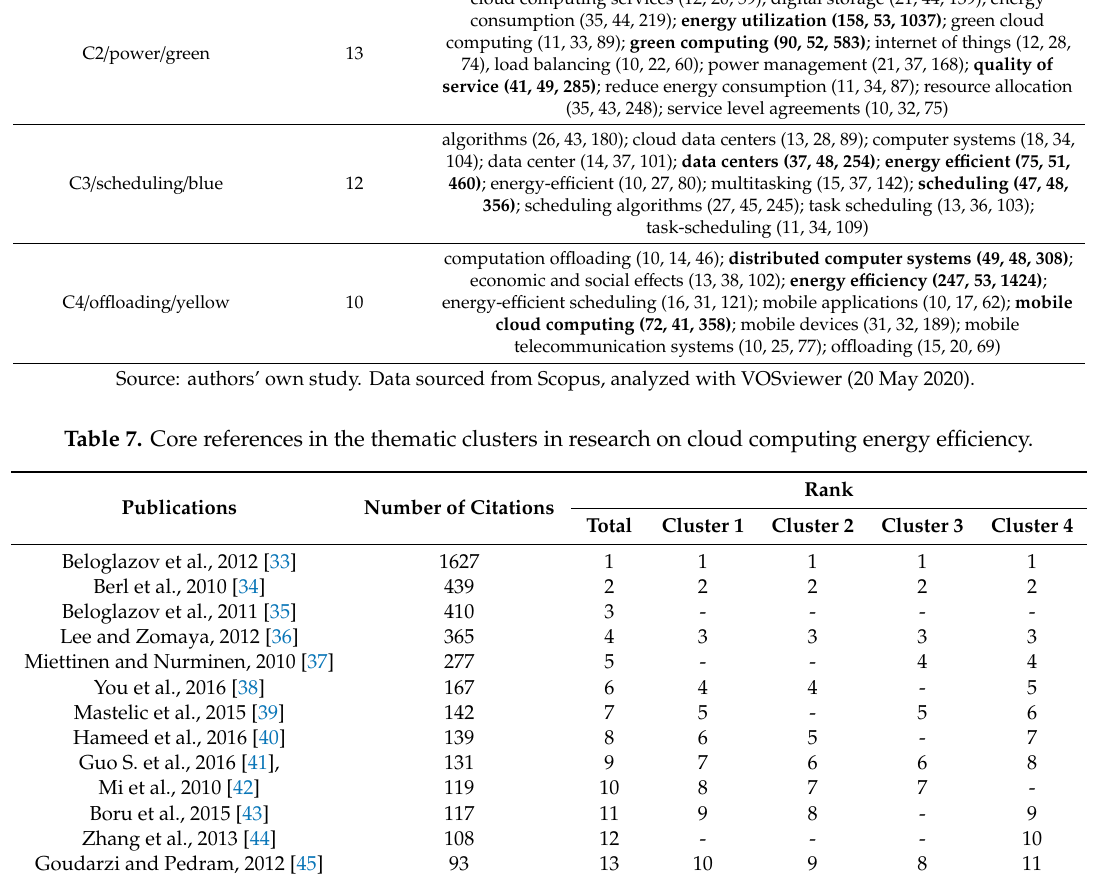
C1 / virtualization / red 18